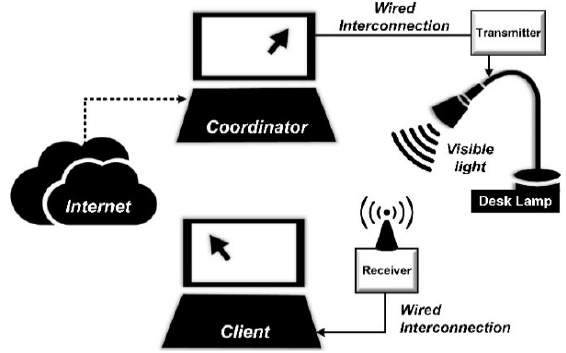
Figure 3. The primary application of proposed VLC system for a short-range personal area network